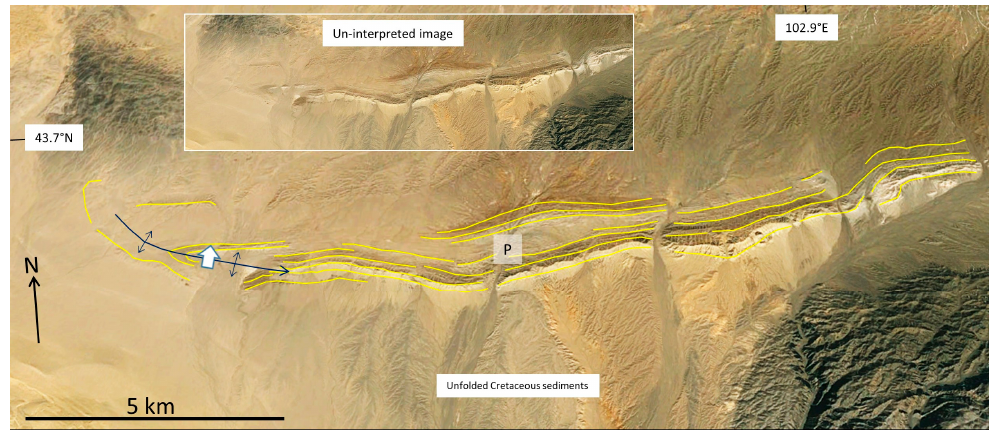
Figure 12. Google Earth image interpretation (2016, CNES Spot Image) showing bedding traces (yellow lines) and major fold hinges in folded Permian (P) sedimentary succession, west end of Dzolen Uul, southeast Gobi Altai. Thick white arrow indicates direction of fold vergence. Inset shows un-interpreted scene. See Figure 1 for location.